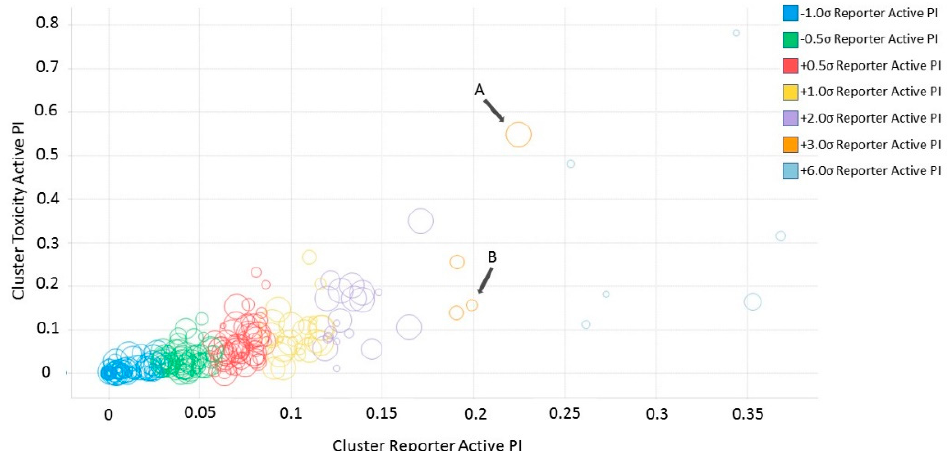
Figure 4. Promiscuity-based classification of chemotype clusters. Similar to Figure 3 for individual compounds, chemotype clusters were visualized based on reporter activity PIsand toxicity activity PIs. Each cluster is represented by one data point sized by number of members within the cluster and colored by total activity PI z-scores. Most clusters resulted as specific and inert (lower left corner). Two clusters, designated A and B, were examined further because of cluster size and high reporter/toxicity PI ratio (A), and molecular scaffold similarity to luciferase inhibitors (B). Compounds with high PIs for both reporter activity and toxicity activity (promiscuous cytotoxic group in Figure 3A) included several extended electron-deficient aromatic systems, including cyanine dyes [(Carbocyanine/Quinaldine Blue (CID 5709754), C3-thiacarbocyanine (CID 16211385),